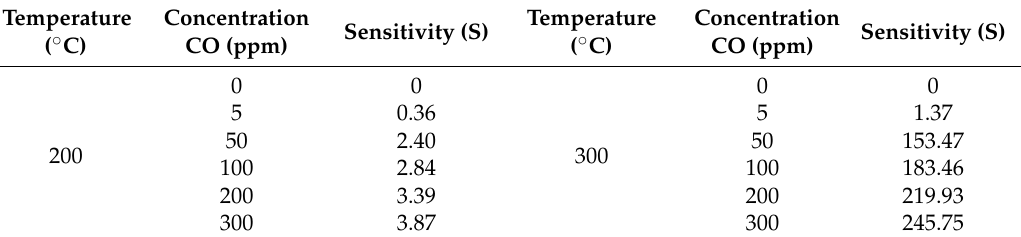
Table 1. Sensitivity values of MgSb 2 O 6 in CO atmospheres.